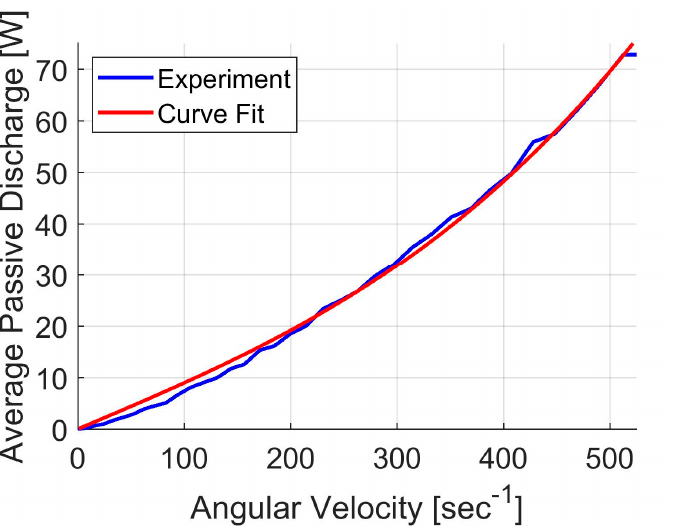
Figure 6. Experimental data and curve fit approximation for the electrical machine passive discharge for the baseline pressure state (intermediate vacuum level). Table 5. Best fit coefficients for the electrical machine passive discharge approximation along with goodness of fit statistical parameters (SSE: error sum of squares, Adj ‐ R2: adjusted R ‐ squared, RMSE: root ‐ mean ‐ squared error).